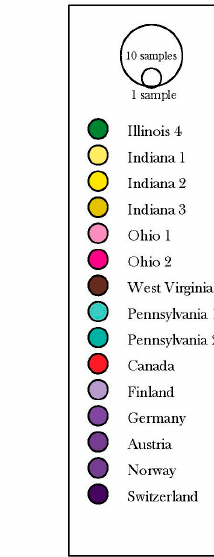
Figure 3. TCS (Templeton-Crandall-Sing) network depicting relationships between COI haplotypes of Depressaria depressana including those collected from sites sampled along a longitudinal gradient from Urbana, IL to Newburg, PA and retrieved from the BOLD database. The size of each circle represents number of individuals belonging to each haplotype (H1–6). The number of hash marks on branches between haplotypes represent the number of mutational steps.